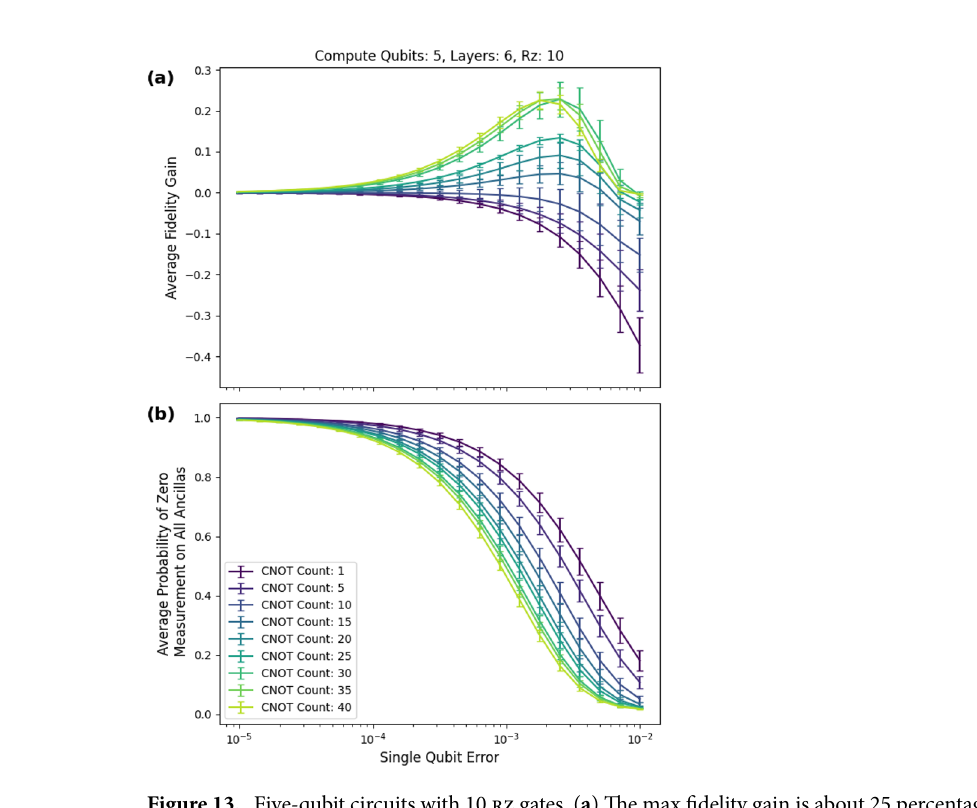
Figure 13. Five-qubit circuits with 10 rz gates. ( a ) The max fidelity gain is about 25 percentage points. ( b ) Probability of postselecting vs single-qubit